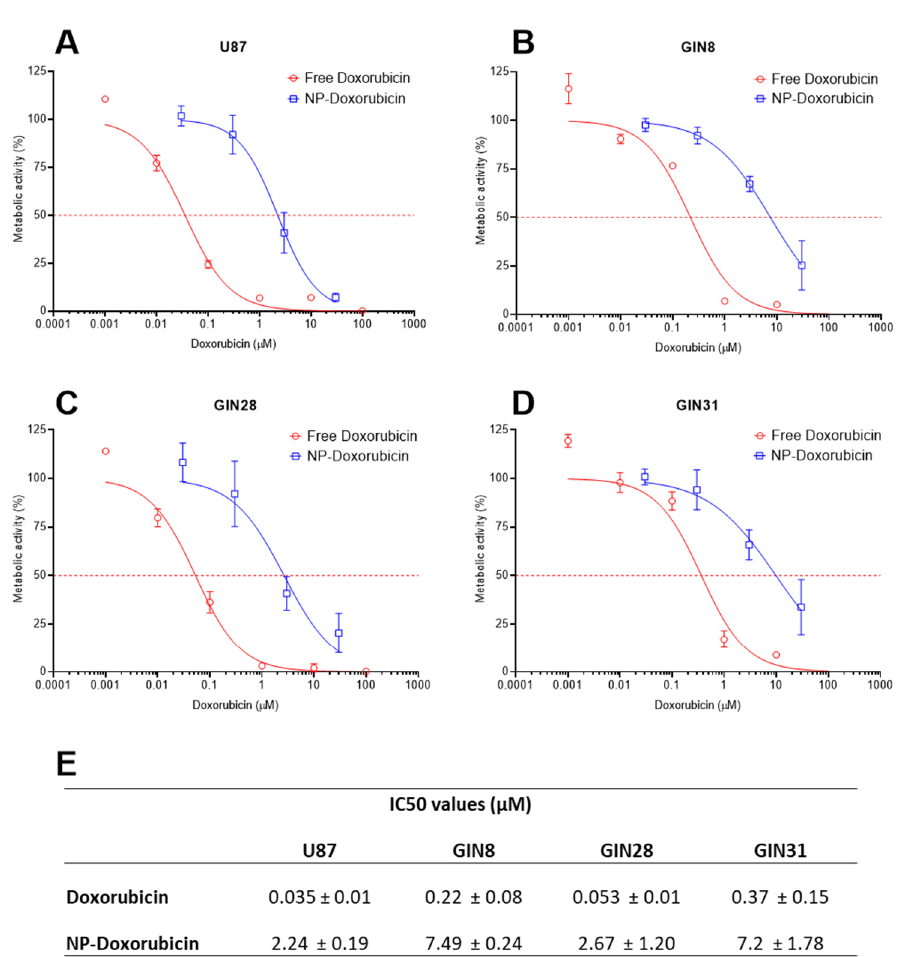
Figure 8. Potency of DOX and DOX-NPs in U87 ( A ), GIN-8 ( B ), GIN-28 ( C ), and GIN-31 ( D ) cell lines. Treatments were applied in DMEM containing 10% FBS and exposed for 72 h. Potency was determined via assessment of cellular metabolic activity using the PrestoBlue assay. Data presented as the mean ± S.D from four independent repeats. IC 50 values (mean ± S.E.M) were calculated and are shown in the table ( E ).